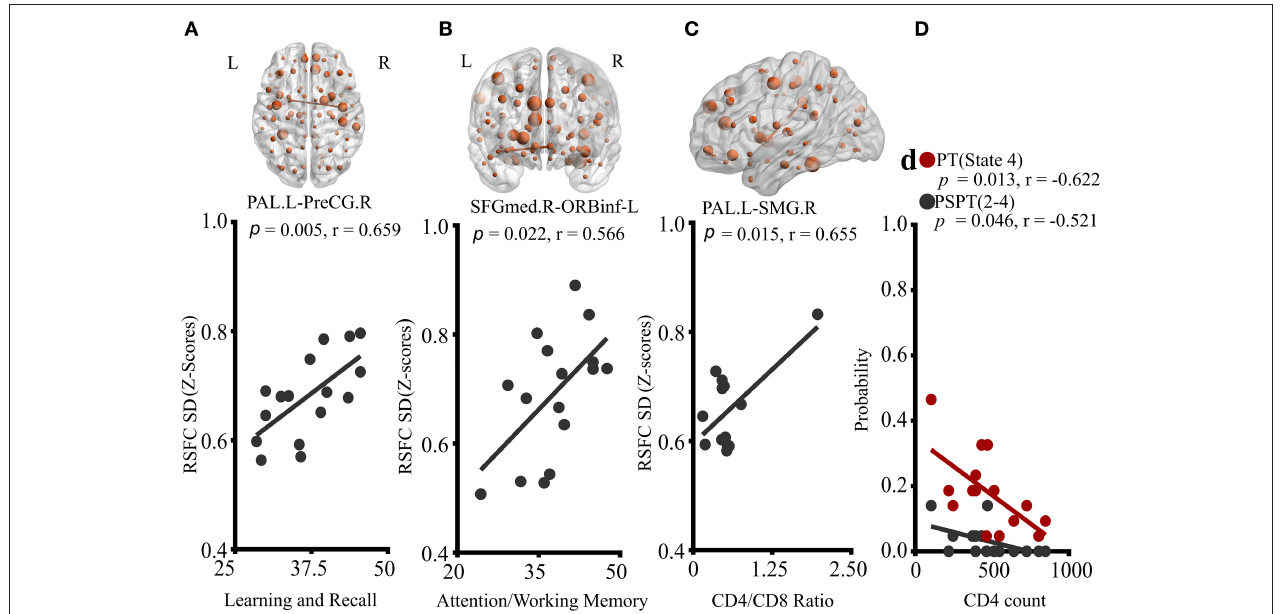
FIGURE 4 | Correlations of properties of dynamic RSFC and RSFC states with clinical characteristics of HIV patients. (A) Correlation of PAL.L-to-PreCG.R temporal variability with learning and recall score. (B) Association of temporal variability of SFGmed.R-to-ORBinf-L with Attention/working memory performance. (C) The relationship between PAL.L-SMG.R variability and CD4 + /CD8 + ratio. (D) Relationships of probabilities of transitioning to state 4, and state-2-to-state-4 transitioning with CD4 + T-cell counts. The displayed relationships were evaluated in Pearson’s correlations coefficients, r ; p < 0.05. P , p -value; L, left; R, right; PAL, the pallidum; PreCG, precentral gyrus; SFGmed, superior frontal (medial) gyrus; ORBinf, pars orbitalis of the inferior frontal gyrus; and SMG, supramarginal